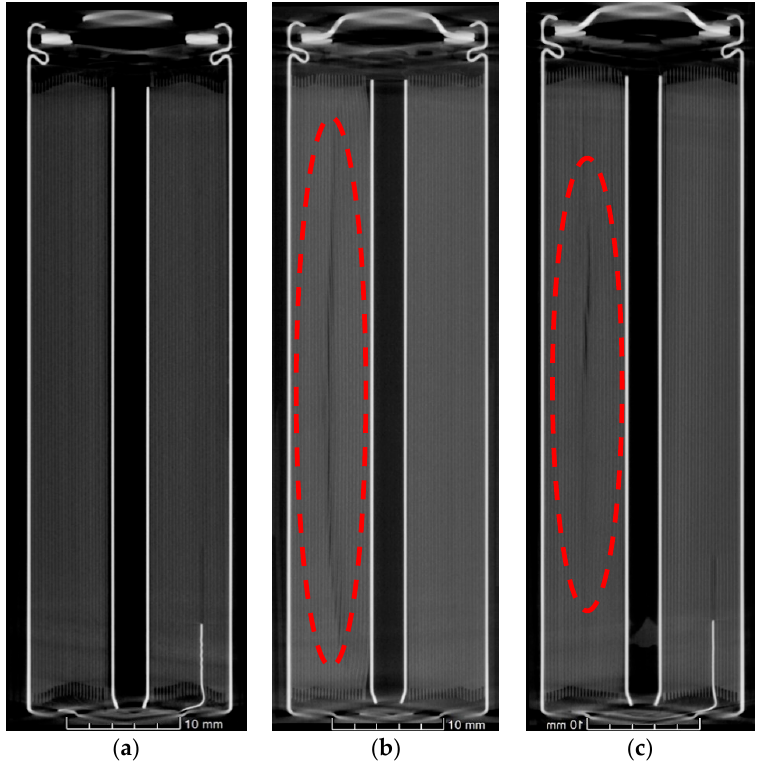
Figure 5. Frontal scans of ( a ) as-received cell ( b ) failure test cell and ( c ) high rate cycled cell. Deformation is indicated by red circles.